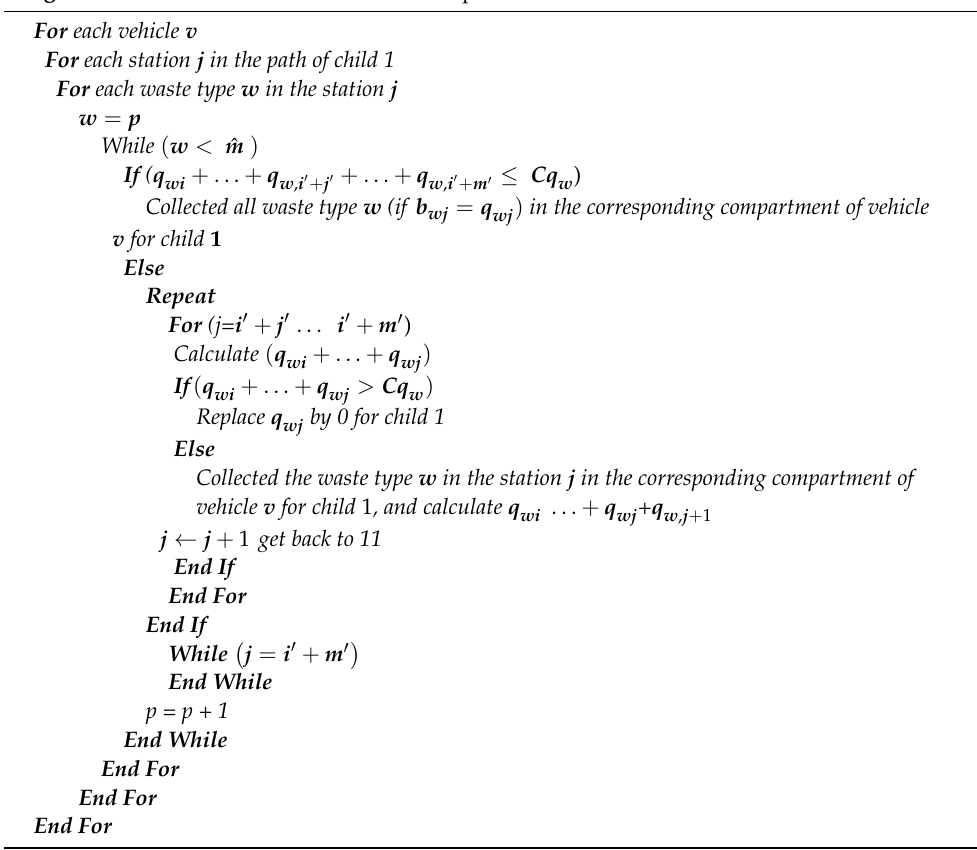
Algorithm 2: Modification of the crossover